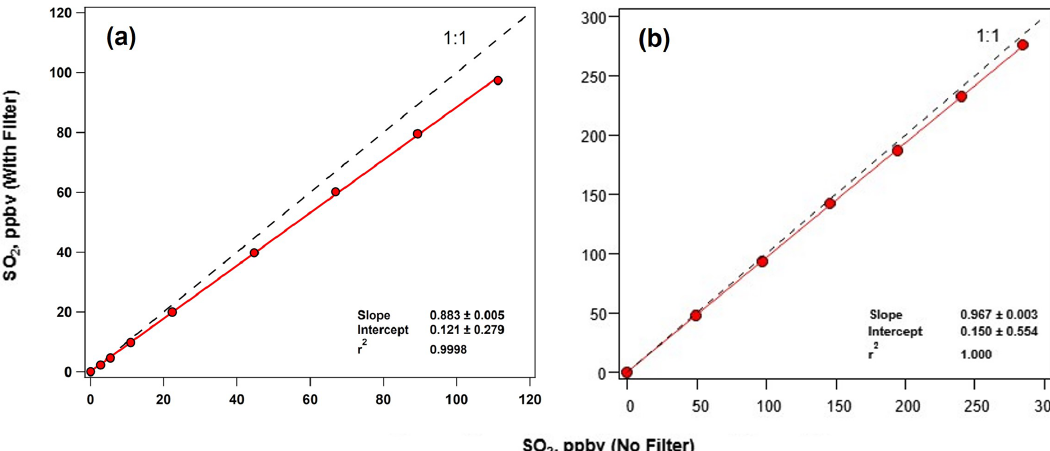
Figure 3. Response of Thermo 43 i − TL SO 2 analyzer with ( y axis) and without ( x axis) an O 3 removal filter using a calibration system with (a) a processed zero-air system and (b) a dry zero-air gas